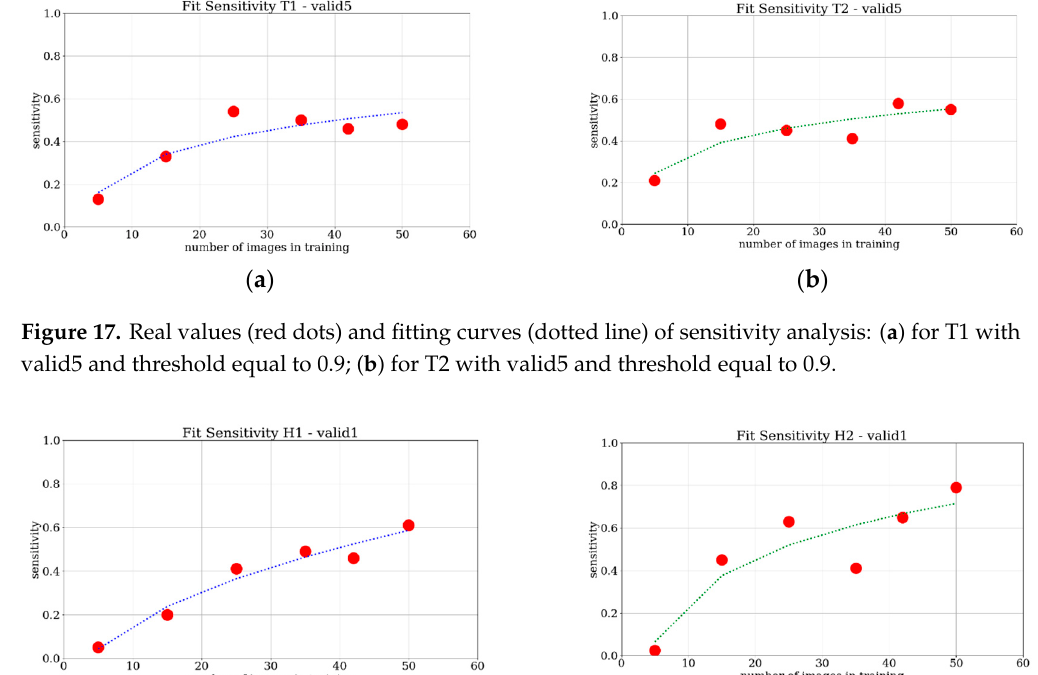
Figure 16. Real values of sensitivity analysis: ( a ) for T1 and T2 with valid5 and threshold equal to 0.9; ( b ) for H1 and H2 with valid1 and threshold equal to 0.9.